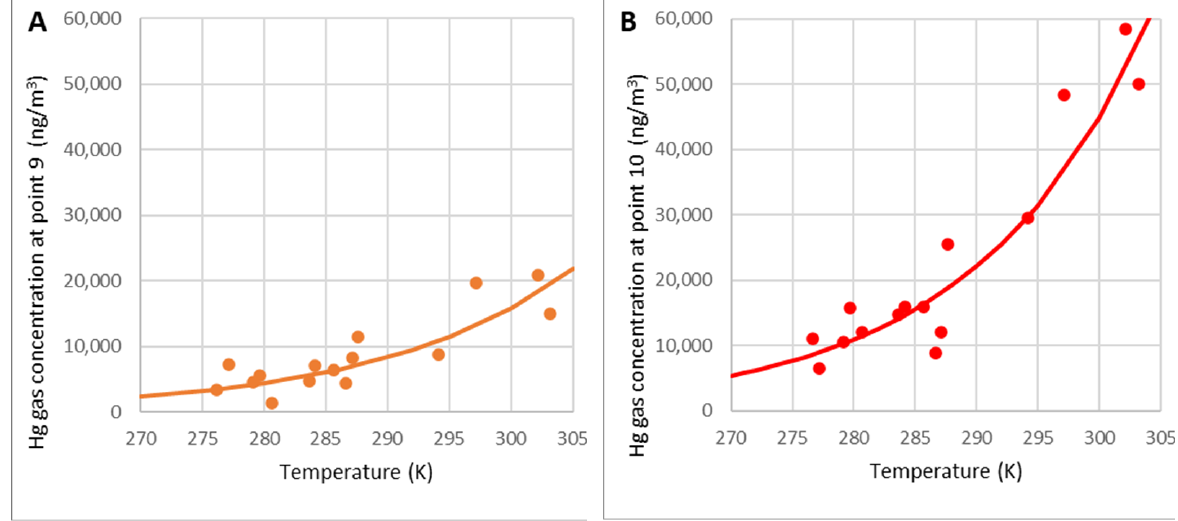
Figure 3. Relationship between temperature and concentration at points 9 ( A ) and 10 (B).